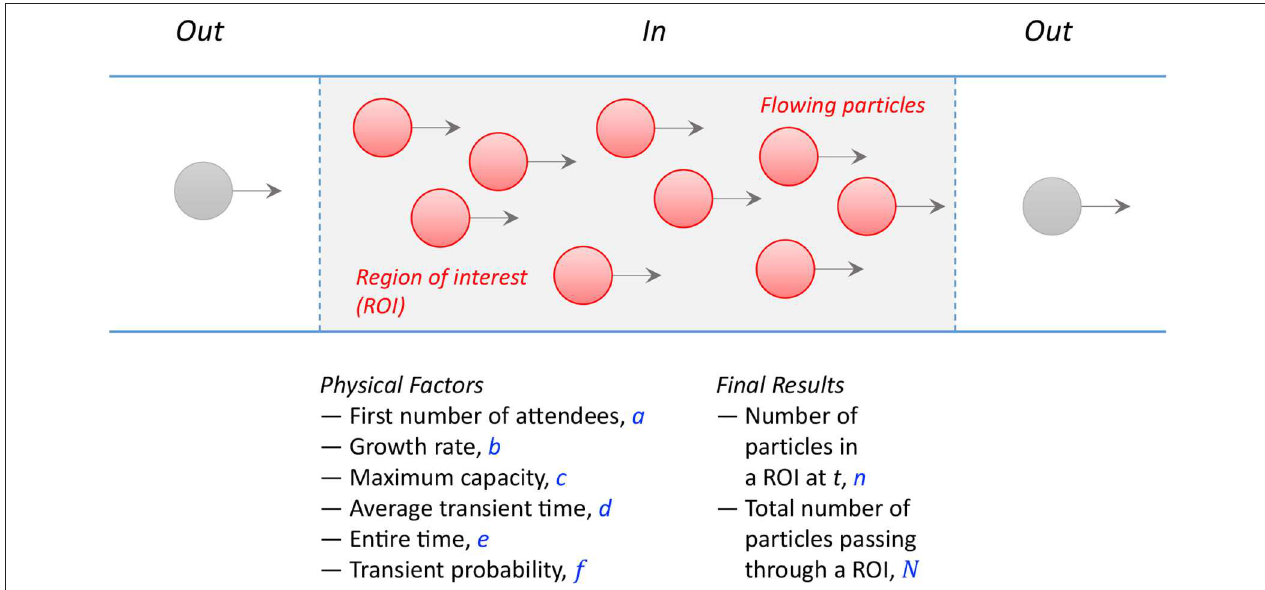
FIGURE 1 | Illustration of a situation: when particles are flowing in a region of interest (ROI, gray) and their physical factors are given ( a ∼ f ), an important question is how many particles ( n or N ) have passed through the ROI during a